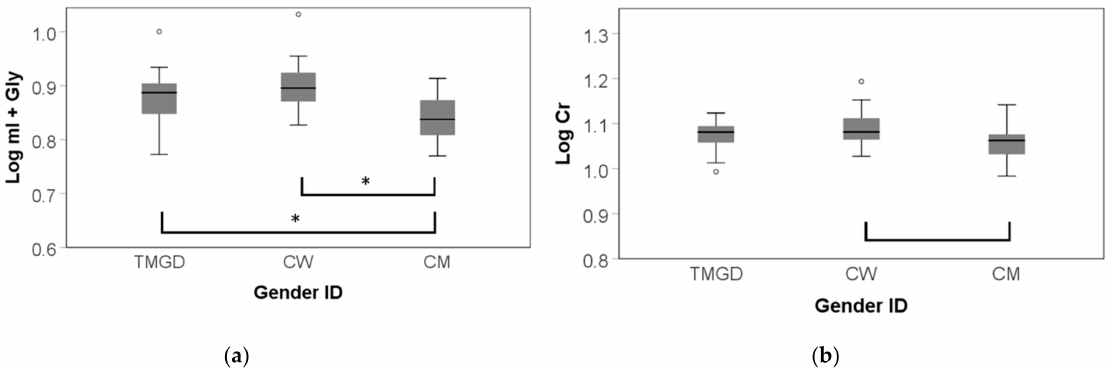
Figure 3. Group distributions of absolute metabolite concentrations in the lateral parietal cortex by gender identity (fender GD). TMGD = trans men with GD; CW = cis women; CM = cis men; * p = <0.05; mild outliers are marked with a circle ( ◦ ). ( a ) Log mI + Gly was significantly lower in CM compared to TMGD and CW; ( b ) Log Cr was nearly significantly higher in CW compared to CM.